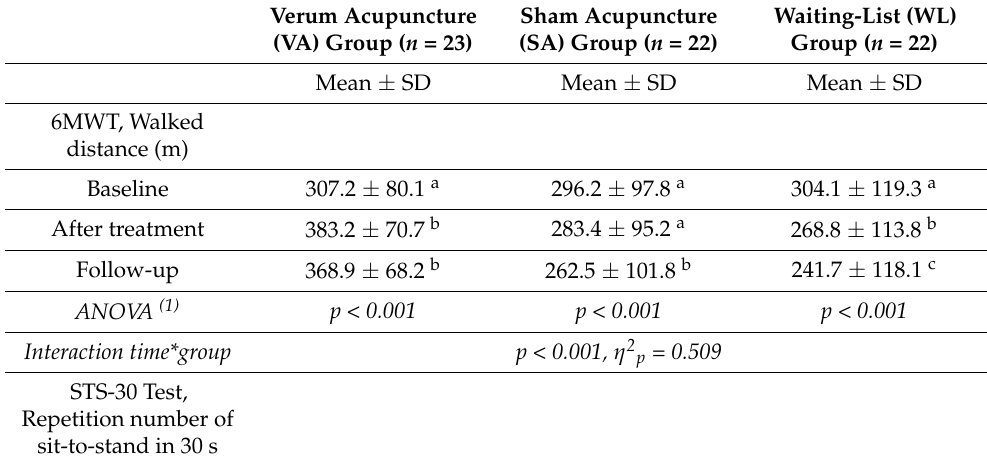
Table 4. Descriptive statistics and comparison of 6-Minute Walk Test (6MWT), 30-Second Sit-to-Stand (STS-30) Test and Handgrip Strength (HGS) Test by group and through